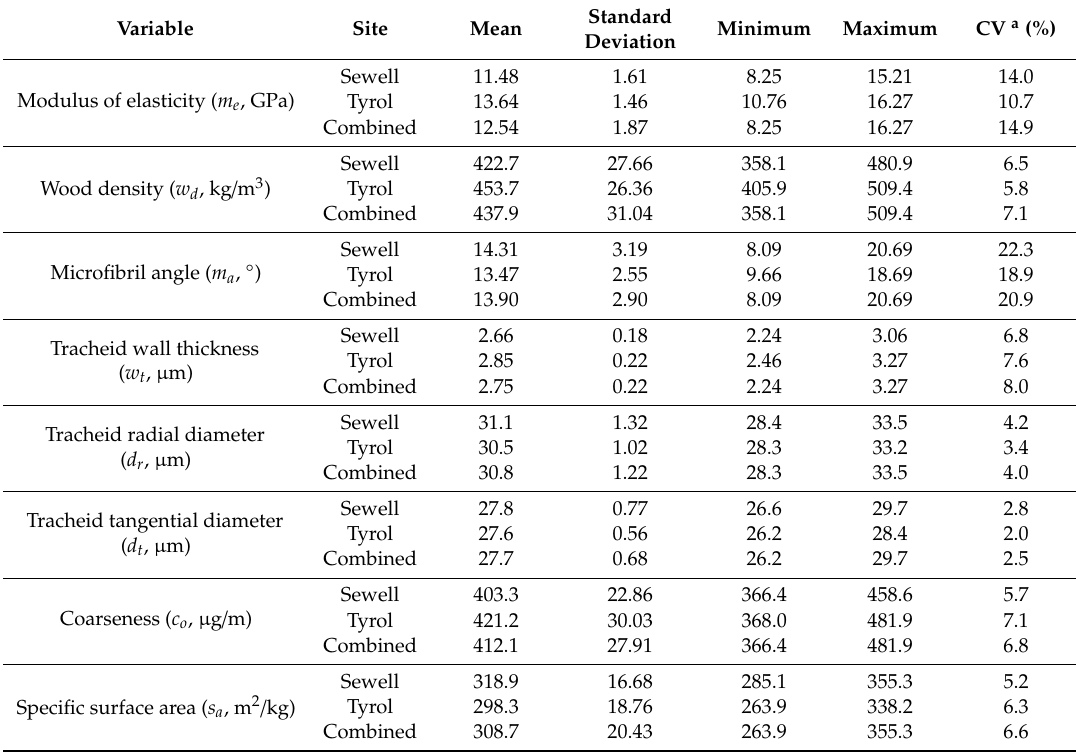
Table 2. Descriptive statistical summary of the cumulative area-weighted fibre attributes at breast-height of the 61 sample trees by site ( n = 31 and n = 30 for Sewell and Tyrol,